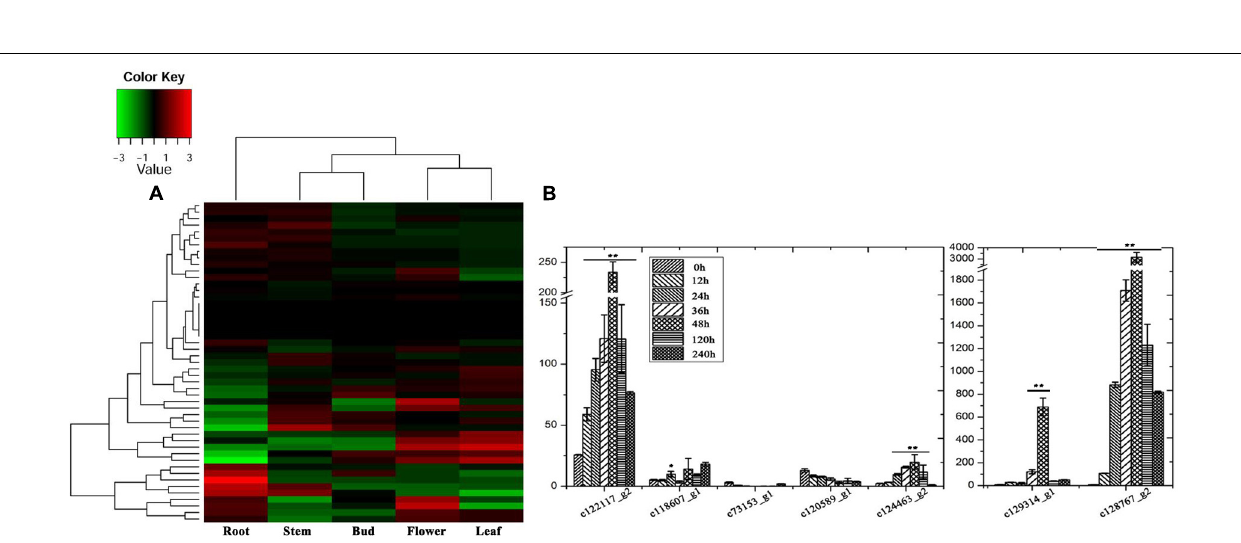
Frontiers in Plant Science |